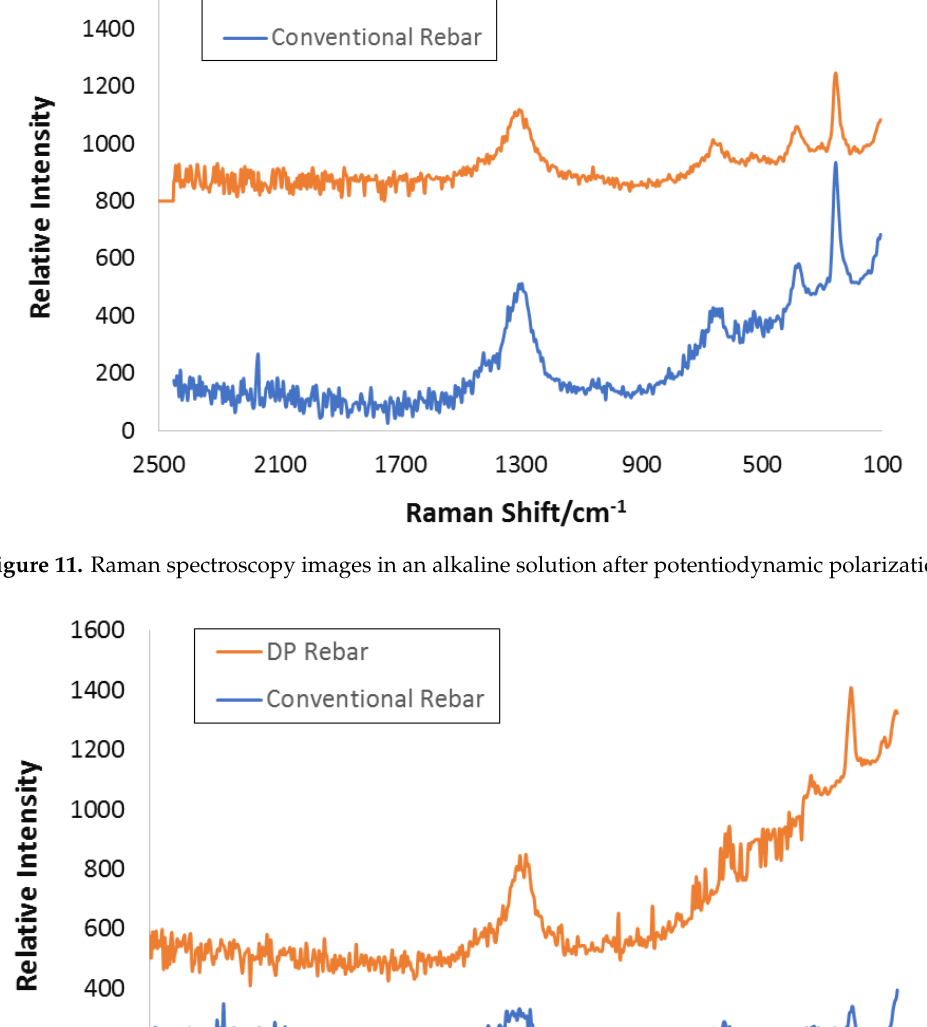
Figure 13. SEM images after potentiodynamic polarization of ( a ) DP rebar and ( b ) conventional rebar.